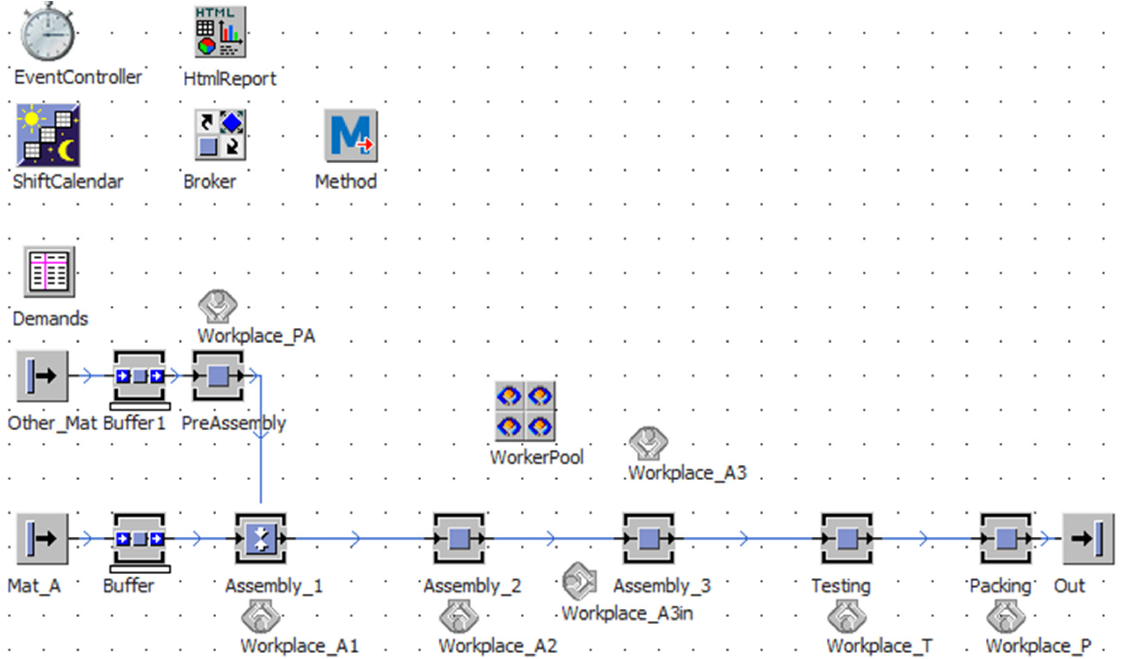
Figure 7. Simulation model of the assembly line—original state.